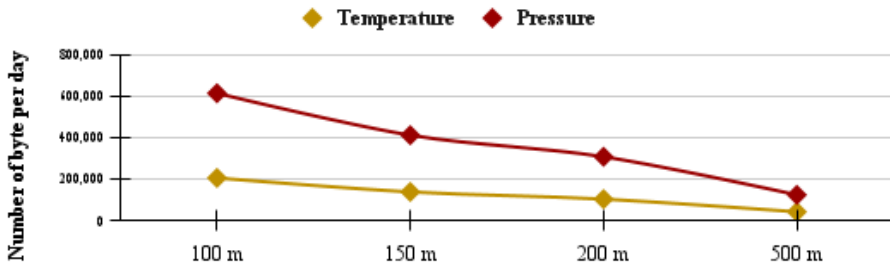
Figure 8. The number of bytes for temperature and pressure sensors at different distances.